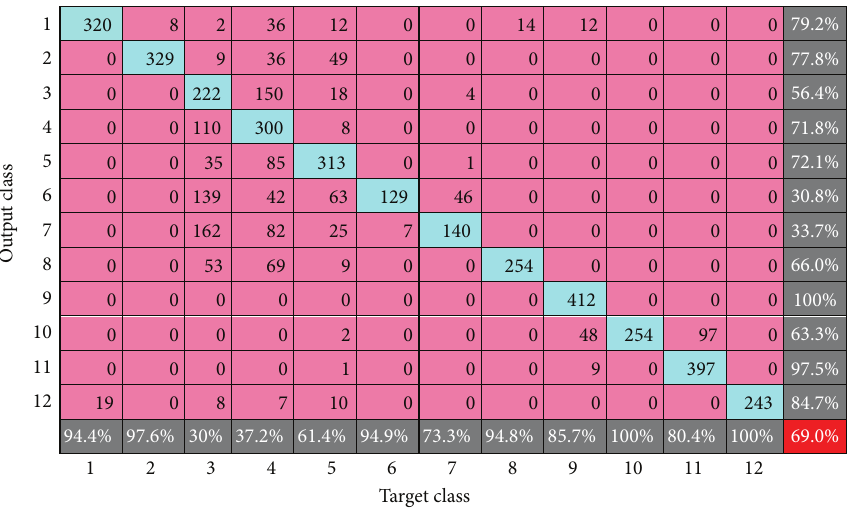
Figure 8: Confusion matrix using SVM.